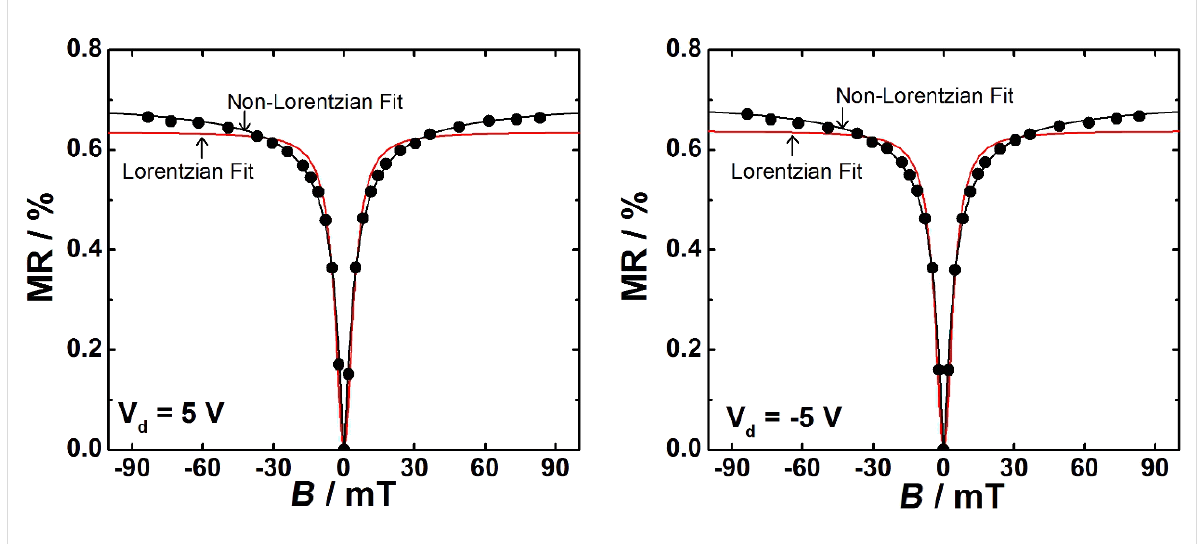
Figure 4: Representative MR line shape curves are shown at V d = − 5 V and +5 V. Black and red lines indicate fits with a Lorentzian (Supporting Infor- mation File 1, Equation S1) and a non-Lorentzian function (Supporting Information File 1, Equation S2), respectively. Hereby, devices with a mixing ratio of 51:49 were used. The applied magnetic fields are higher than 2 mT and V g was zero for all measurements.